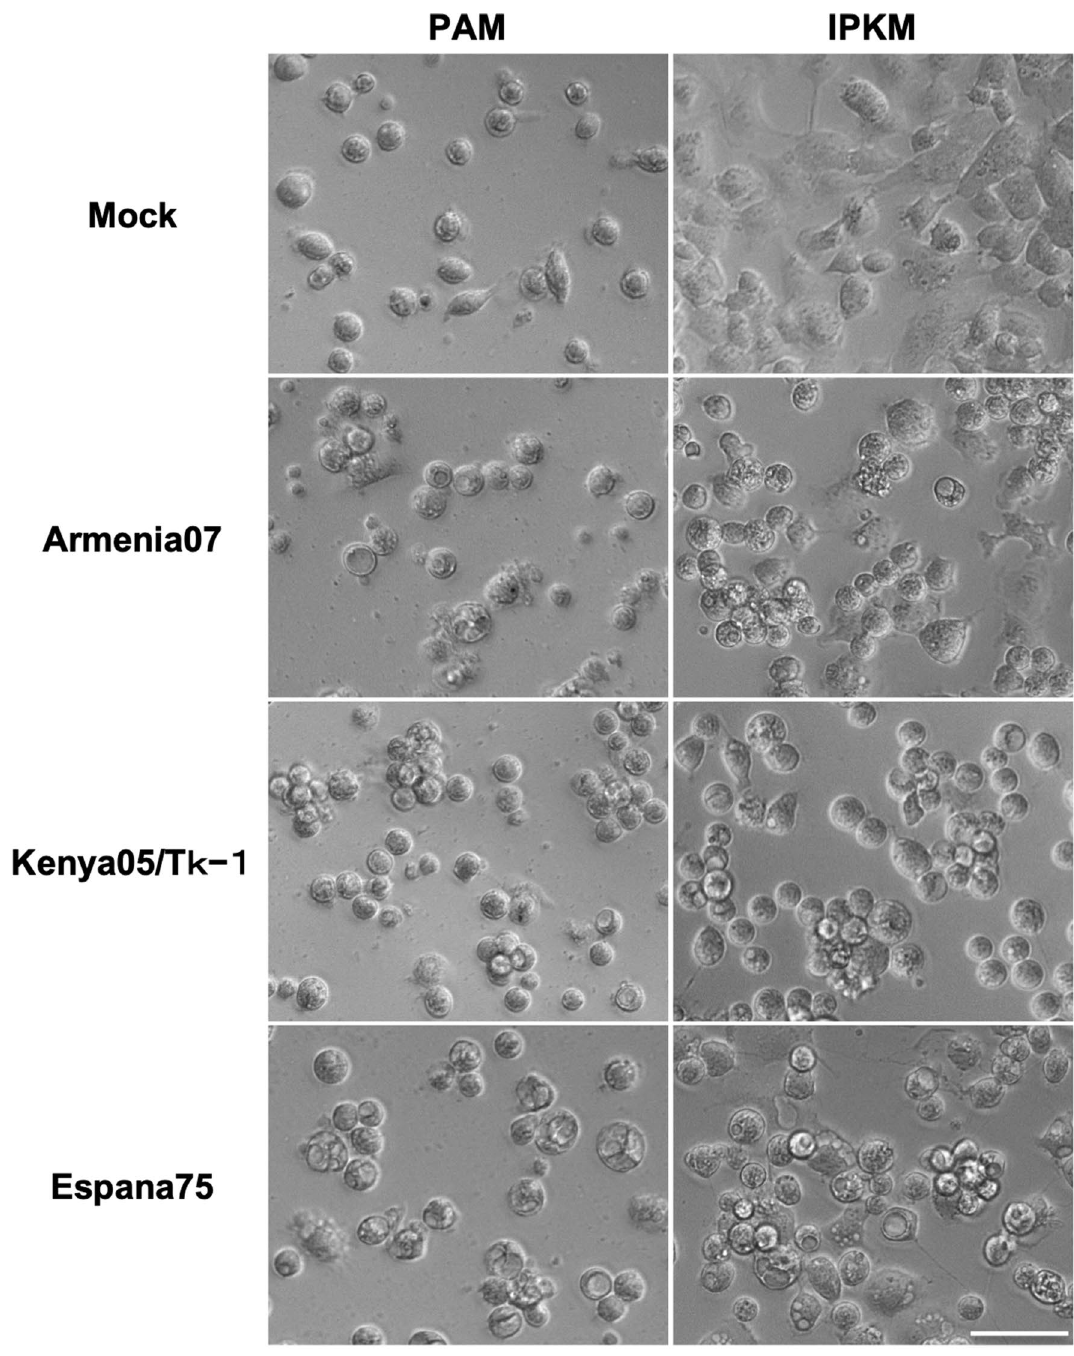
Figure 2. Cytopathic effects in primary porcine alveolar macrophages (PAM) and immortalized porcine kidney macrophages (IPKM). Cell cultures were mock-inoculated or inoculated with Armenia07, Kenya05/Tk-1 and Espana75 isolates (MOI = 0.1). The left and right columns show the PAM and IPKM cell lines at 3 days after inoculation, respectively. Images are representatives from three experiments that demonstrated similar trends. Bar = 50